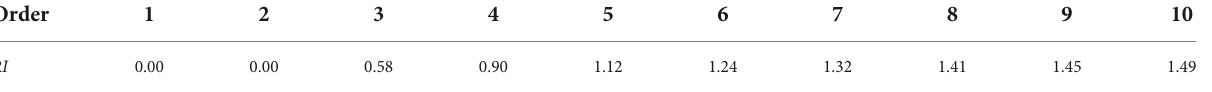
TABLE 7 Average random consistency indicator of the judgment